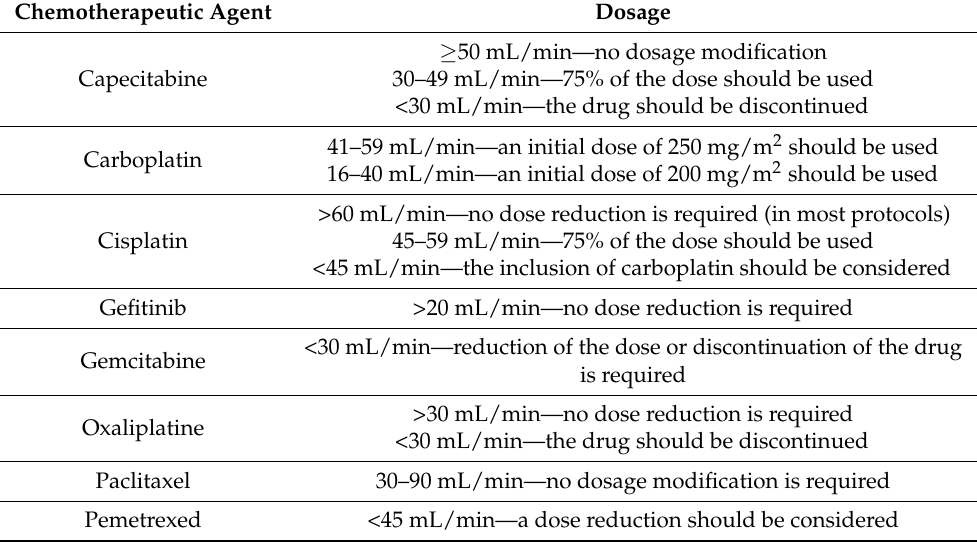
Table 1. Drug dosage adjustments based on creatinine